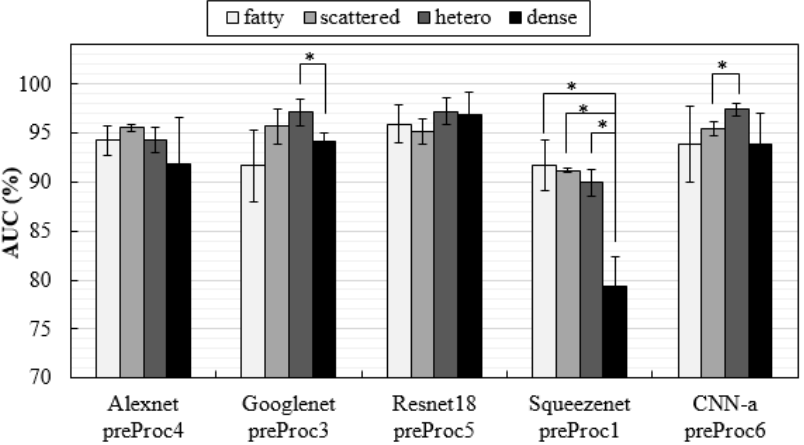
Figure 8. AUC values obtained with test datasets composed by the four different breast densities separately (* p < 0.05 indicates a significant difference between groups).